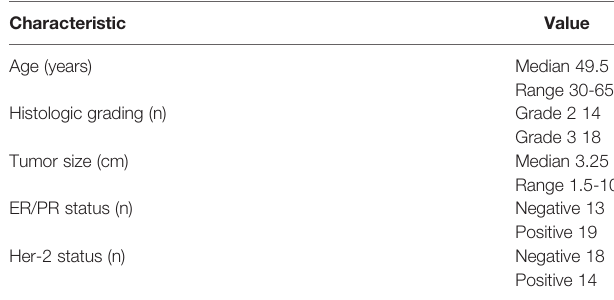
TABLE 1 | Patient